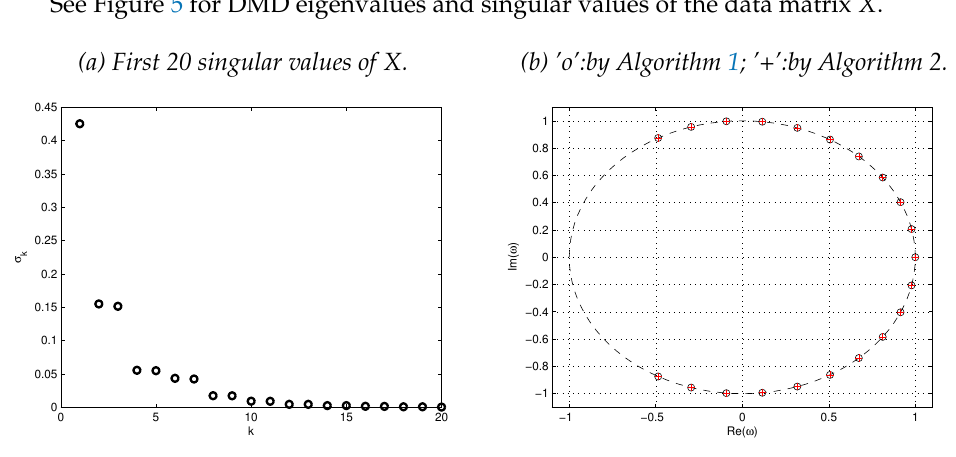
Figure 5. Singular values of X ( a ) and DMD eigenvalues computed by Algorithms 1 and 2 ( b ). Figure 6 shows the first six DMD modes computed by Algorithms 1 and 2, respectively. The only difference is in the visualization, with contour lines added to the DMD modes obtained by Algorithm 2 (otherwise we obtain the same picture).